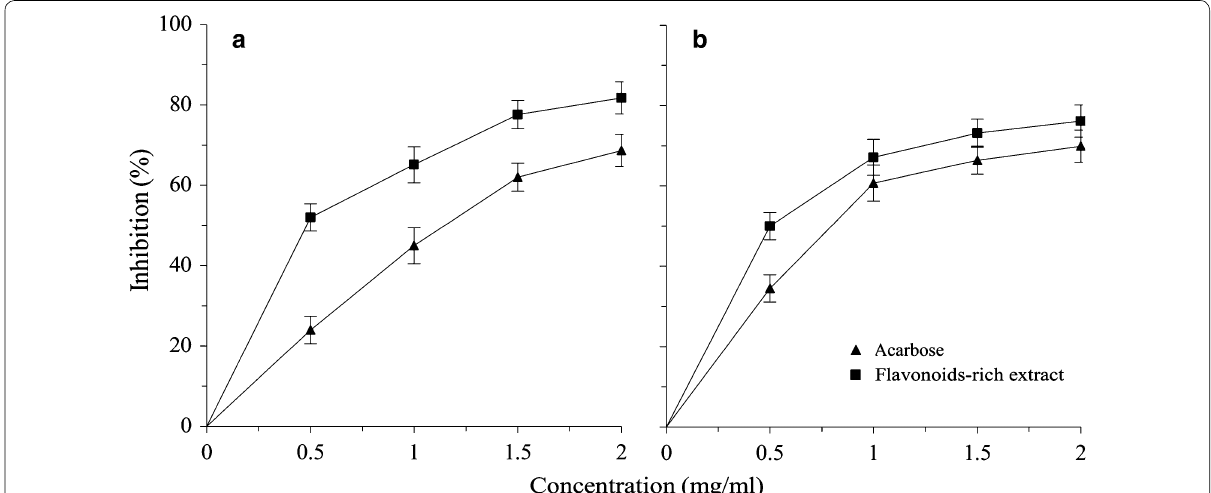
Fig. 1 Inhibitory effects of the flavonoids-rich extract from S. baicalensis shoots at different concentrations (0, 0.5, 1, 1.5, and 2 mg/mL) against α-glucosidase ( a ) and α-amylase ( b ). Acarbose was used as the positive control to ensure that the results were reliable. Results were presented as mean SD of three independent experiments (n ± =